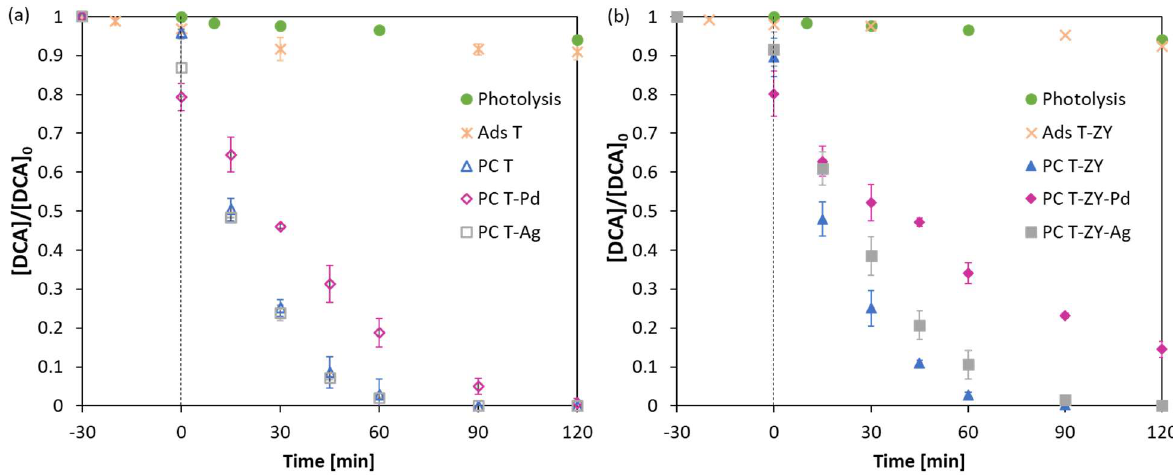
Figure 4. Change with time in dimensionless DCA concentration in aqueous solutions in the presence of ( a ) TiO 2 and TiO 2 -metal composites and ( b ) T–ZY and T–ZY metal composites irradiated with UV–A source at 365 nm. Additionally, control experiments evaluating DCA adsorption in pure TiO 2 ( a ) and TiO 2 –5%ZY mixtures ( b ) in absence of light and photolysis of DCA ( a ) are included.